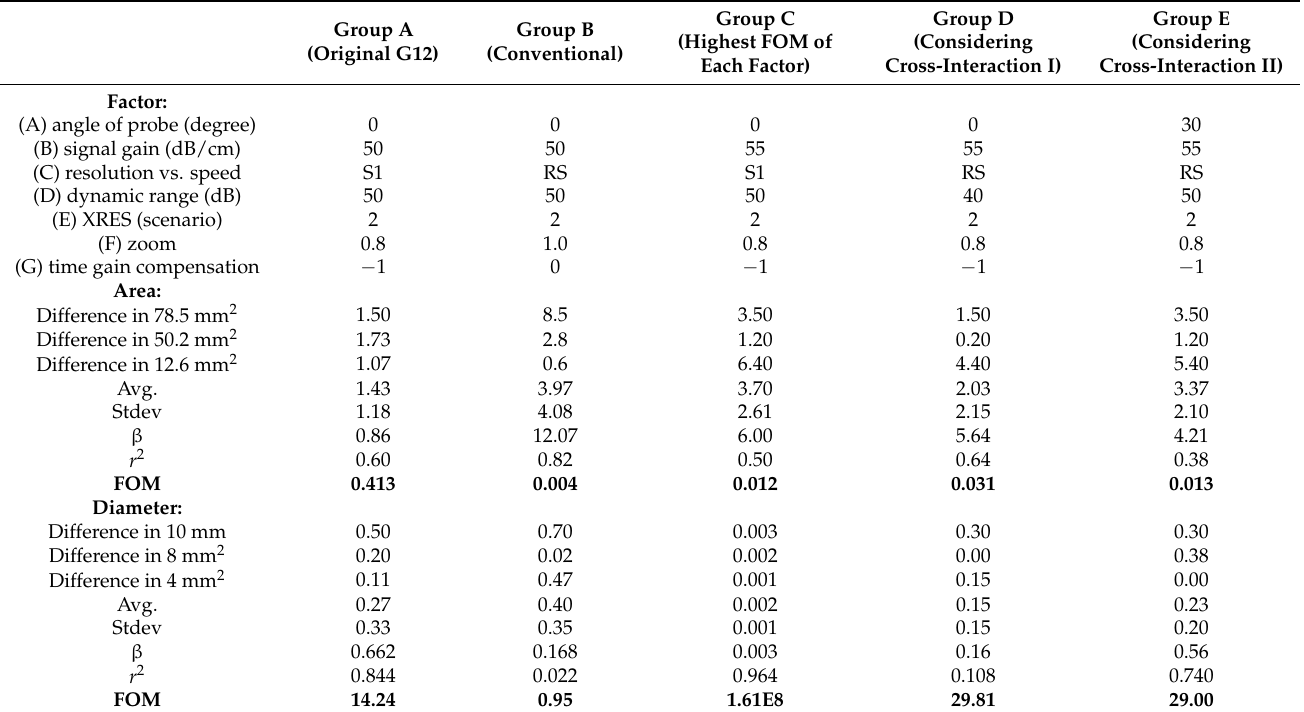
Table 4. Four groups of factor combinations of ultrasound facility to verify the optimal sugges- tion according to different scenarios: A. original group 12, the highest FOM among 18 groups; B. conventional suggestion; C. the combination of highest FOM of each factor; D. considering the cross-interaction among factors I; and E.